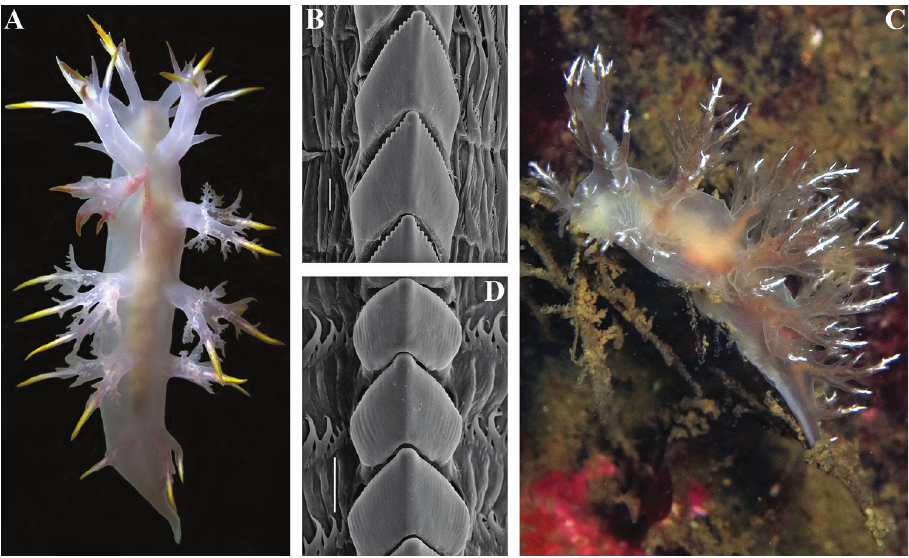
Figure 4. A Dendronotus albus MacFarland, 1966, live specimen ZMMU Op-566, dorsal view, Rich Passage, NE Pacific B same, posterior radular teeth, SEM C Dendronotus kamchaticus Ekimova et al., 2015, live specimen ZMMU Op-565, dorsal and lateral view, Rich Passage, NE Pacific D same, posterior radular teeth, SEM. Scale bars B, D = 30 µm. Photos of living specimens by Karin Fletcher, SEM images by Alexander